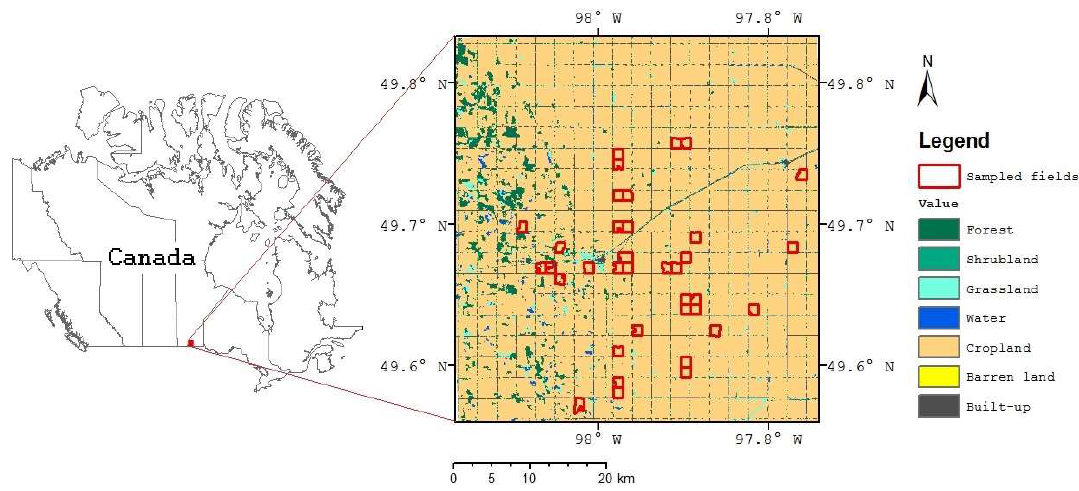
Figure 1. Study site and sampled fields (Basemap: Land Cover of Canada [29]).